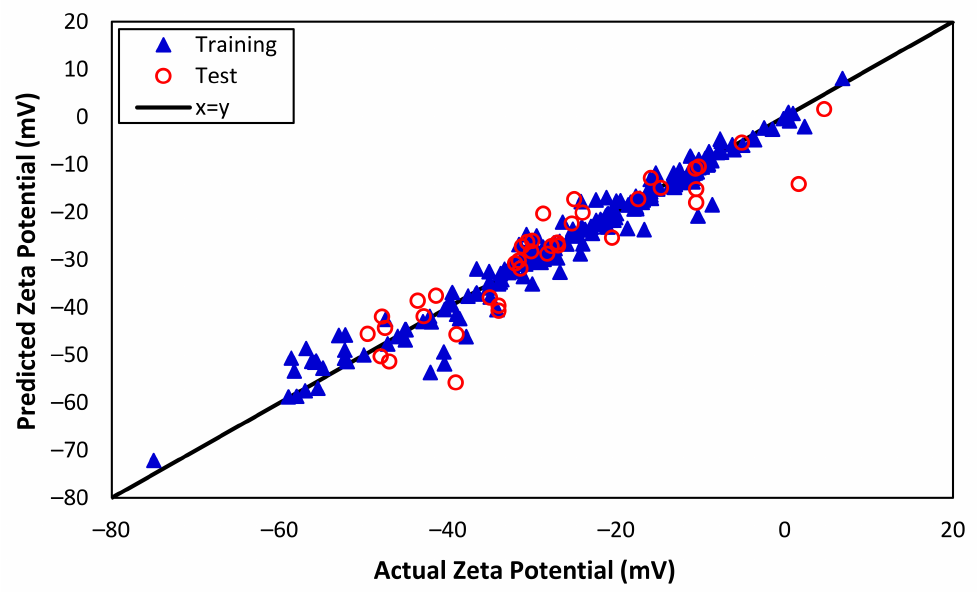
Figure 5. Actual and predicted zeta potentials from ANN (training and test